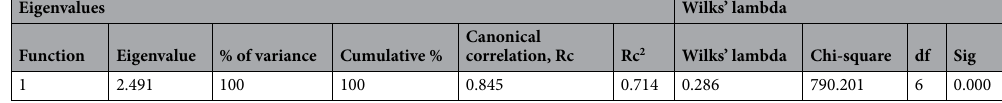
Eigenvalues Wilks’ lambda Function Eigenvalue % of variance Cumulative %